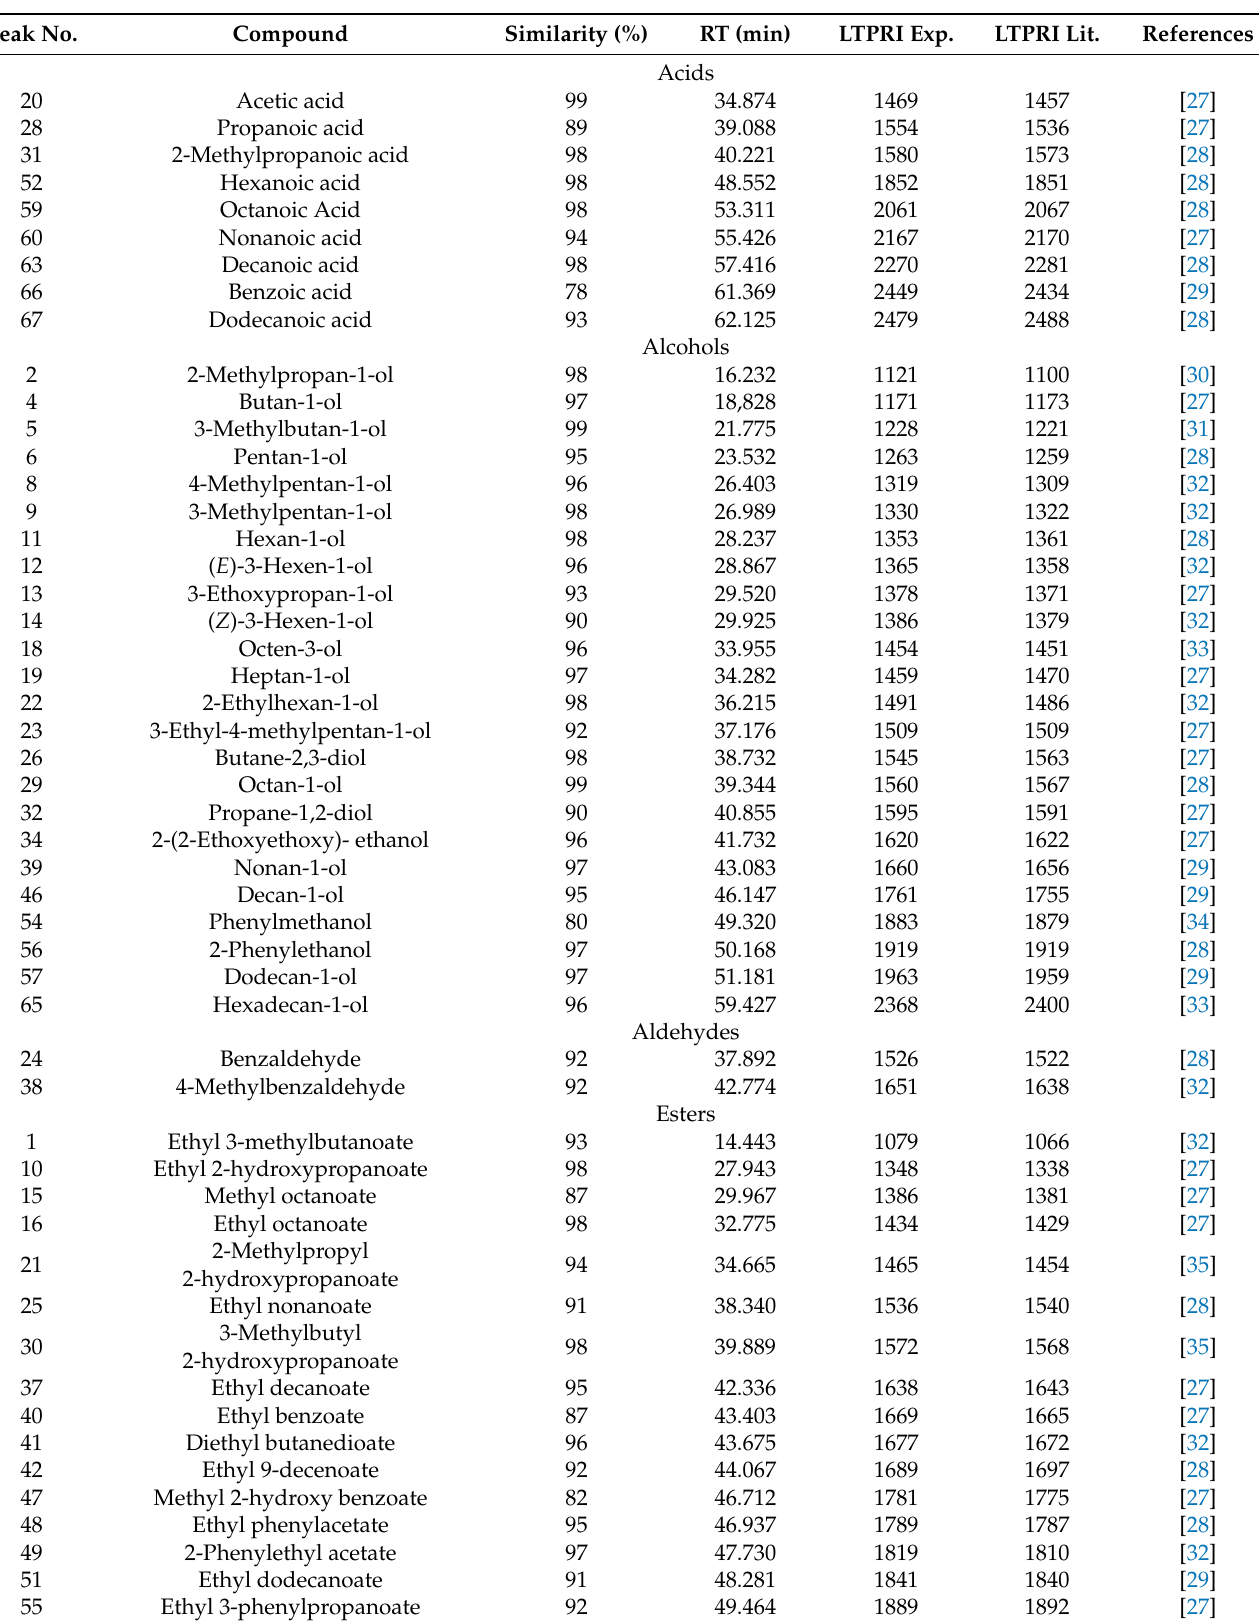
Table 1. Volatile compounds identified in Zweigelt and Rondo